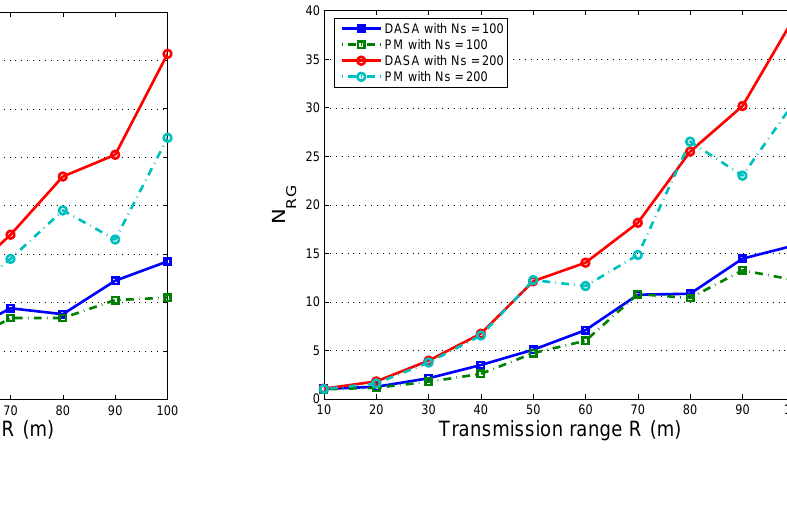
with varying the transmission range RG